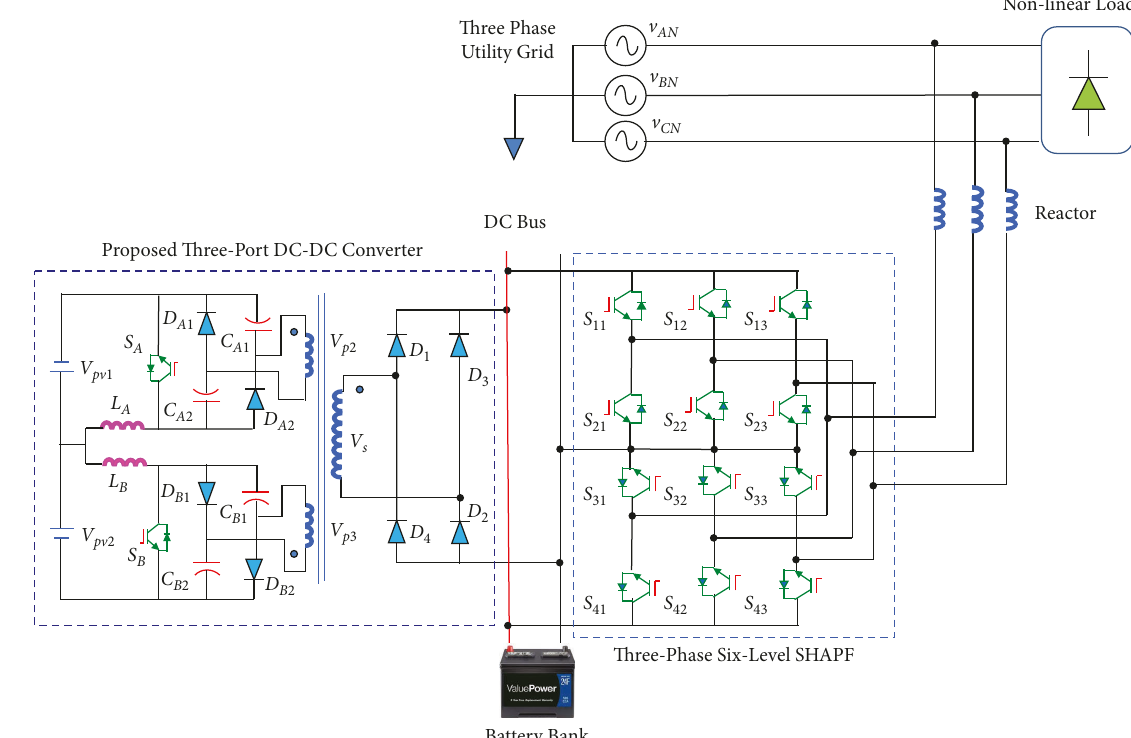
Figure 4: Circuit diagram of the proposed PV-tied MTIIFC powered SHAPF.